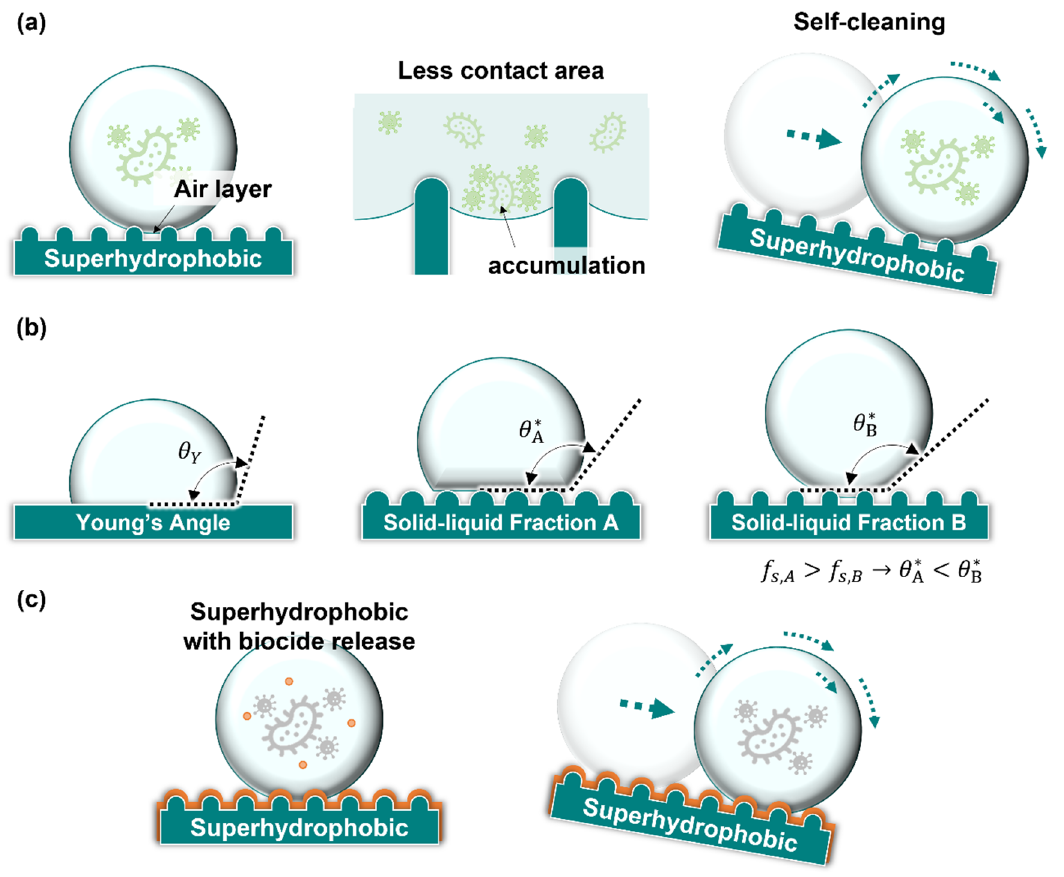
Figure 3. Antimicrobial mechanism of Cassie droplet on superhydrophobic surfaces. ( a ) Anti-biofouling mechanism of the Cassie droplet (compared with the Wenzel droplet) provides a smaller contact area between the liquid and the surface, allowing microbes to gather at the liquid-vapor interface between structures. At the same time, the cleaning characteristic of droplets takes the microbes off the surface. ( b ) Cassie droplet shows that the smaller the solid-liquid fraction, the greater the apparent contact angle is. ( c ) Superhydrophobic surfaces with biocide release kill microbes and bring the microbes off the surface. The green arrows indicate the direction of droplet movement and rotation on the superhydrophobic surface.